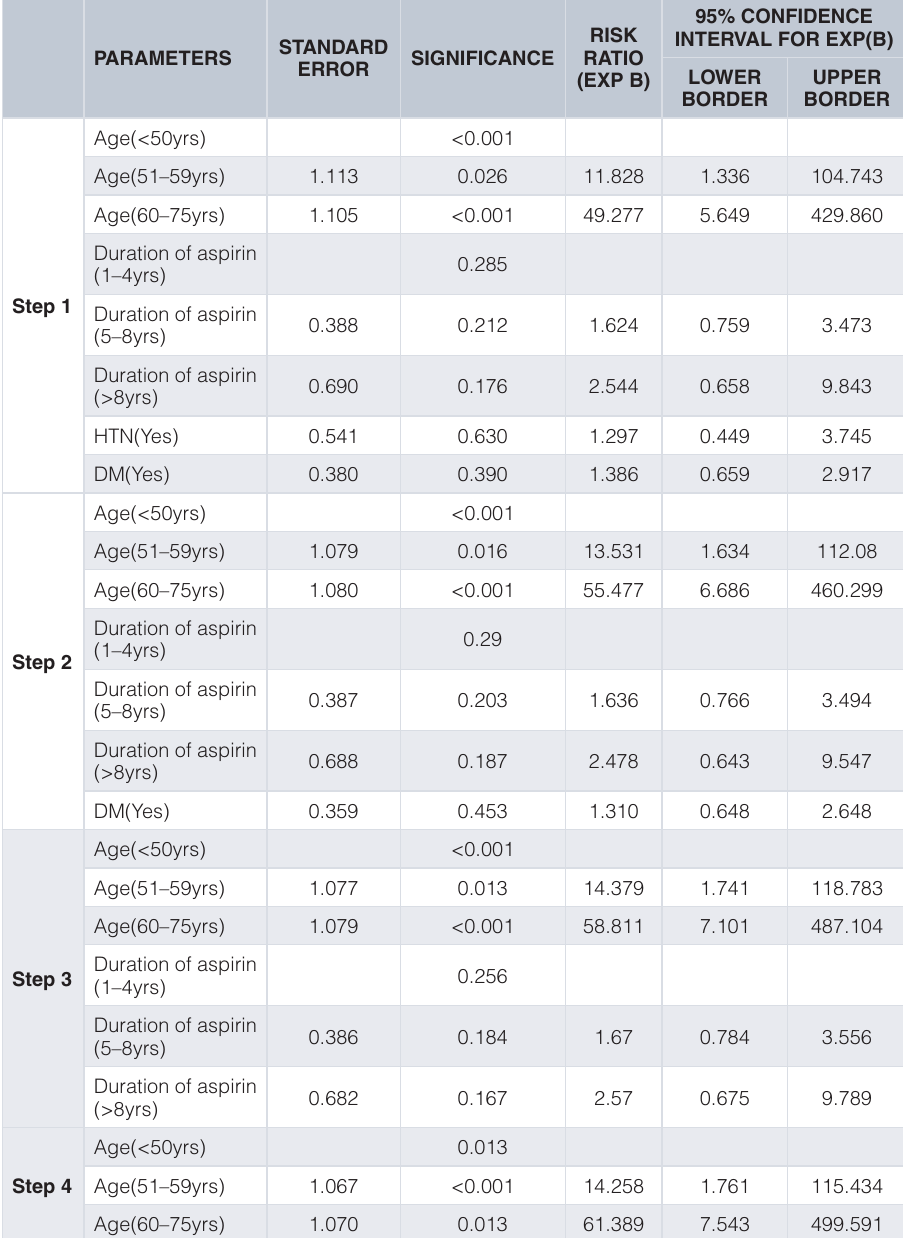
Table 2. Regression analysis of age, duration of aspirin intake, hypertension (HTN) and diabetes (DM) with hearing loss (182